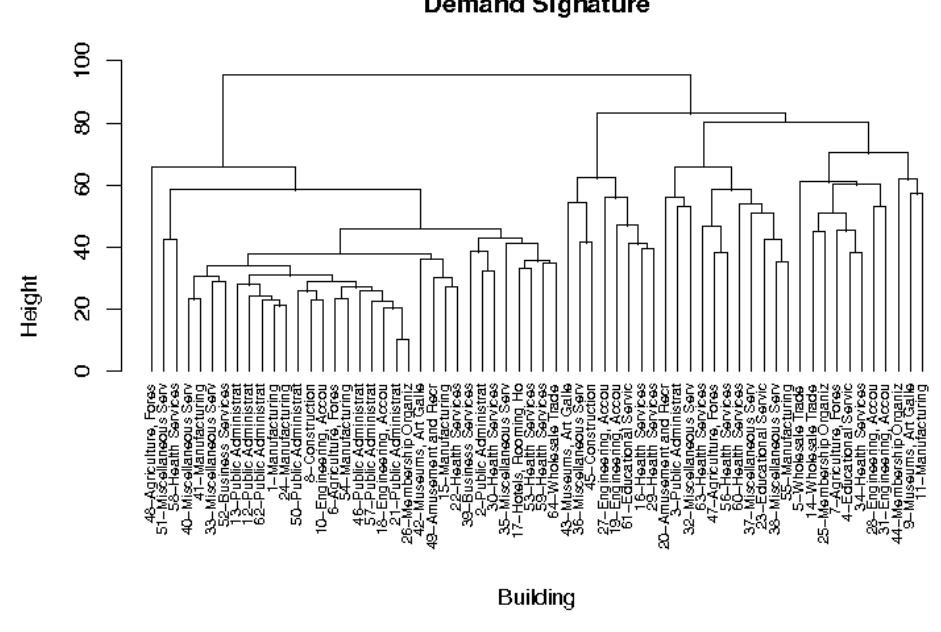
Figure 7. Classification of customers based on the demand